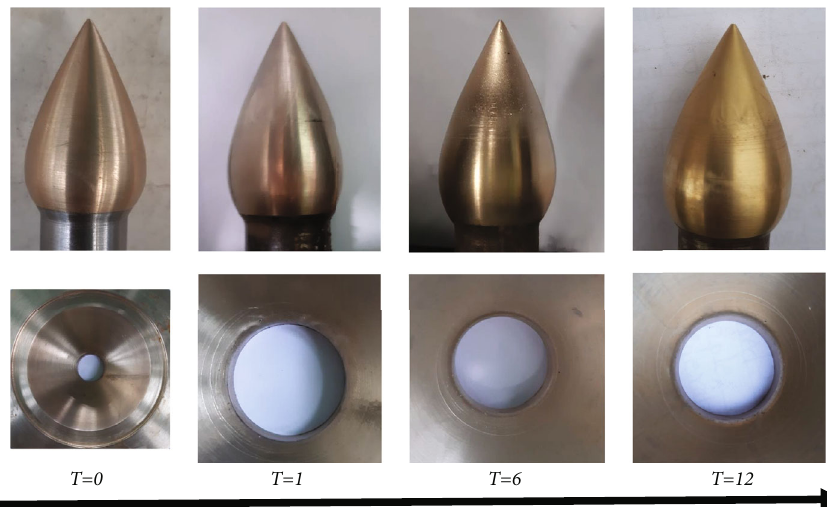
Figure 10: Needle and nozzle erosion at 50% opening at a fi xed time interval (time in hrs.)